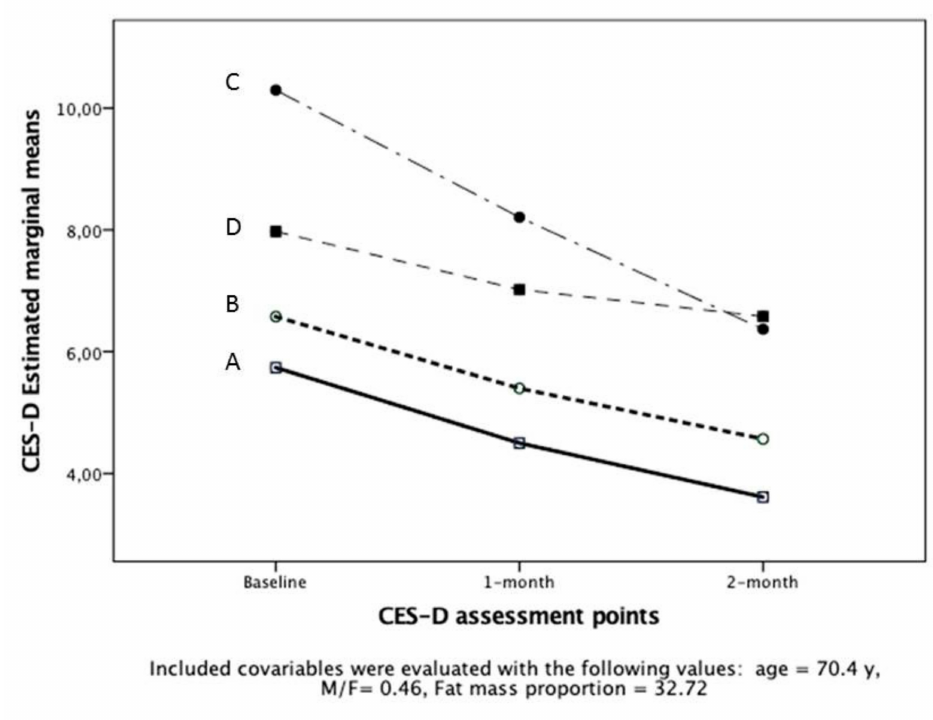
Figure 1. Changes in CES-D score according to time and intervention groups with adjustments for age, gender, and body fat